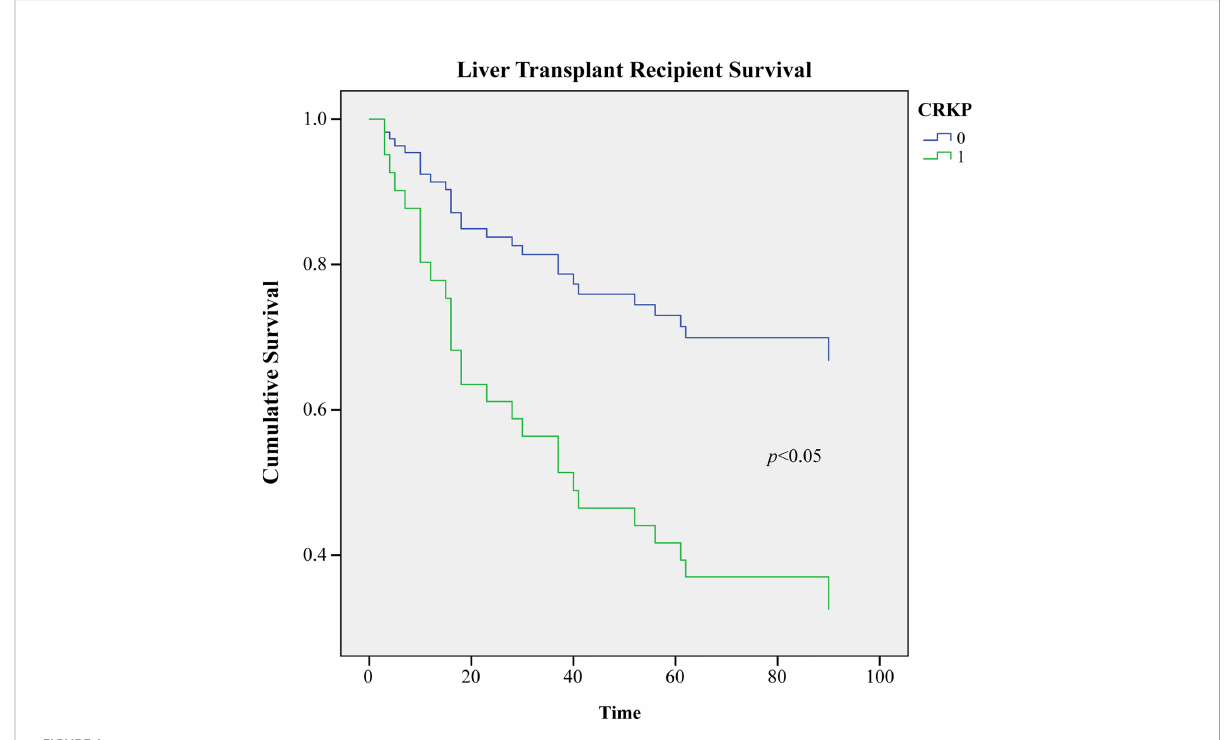
FIGURE 1 Comparison of the 3-months survival rate of infected and uninfected CRKP among early Liver Transplant recipients ( p